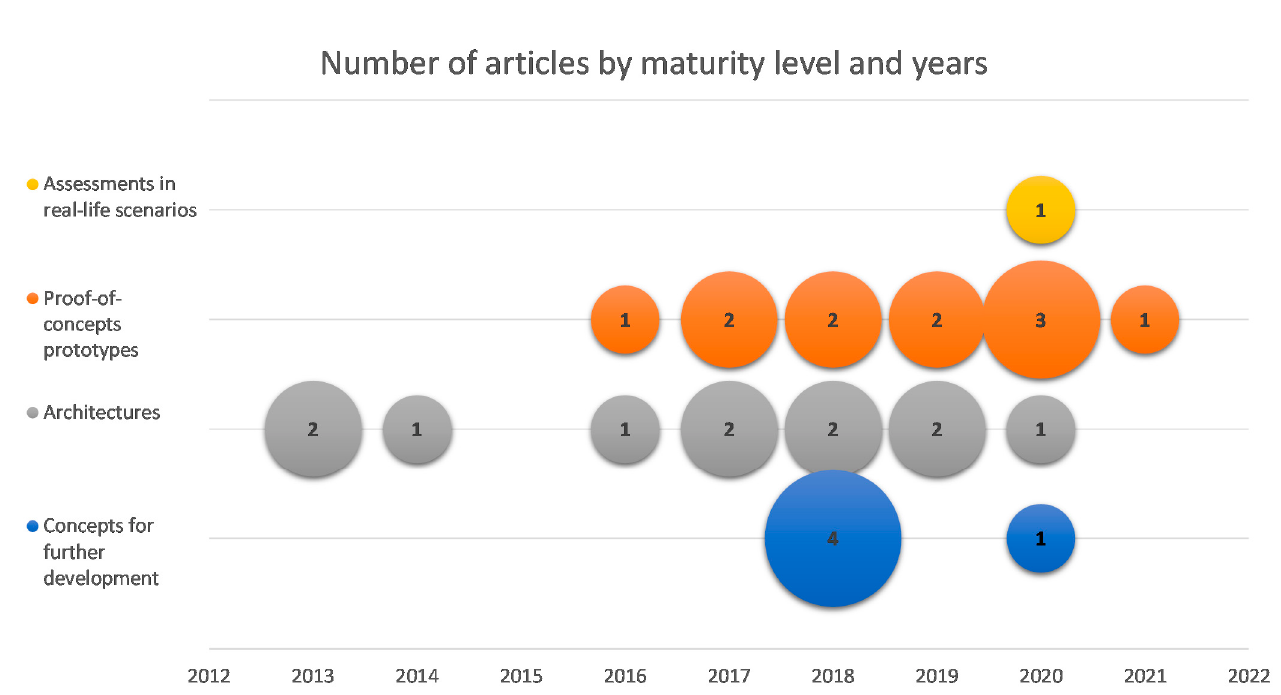
Figure 6. Number of articles by maturity level and years.